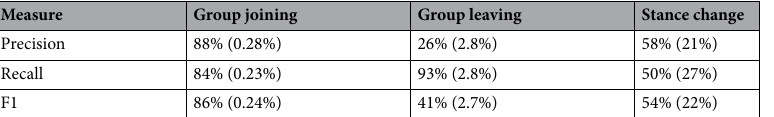
Table 4. Performance of the models. A comparison of the Precision, Recall, and F1 between the analytical model and the random baseline model. The baseline model’s results are included in the